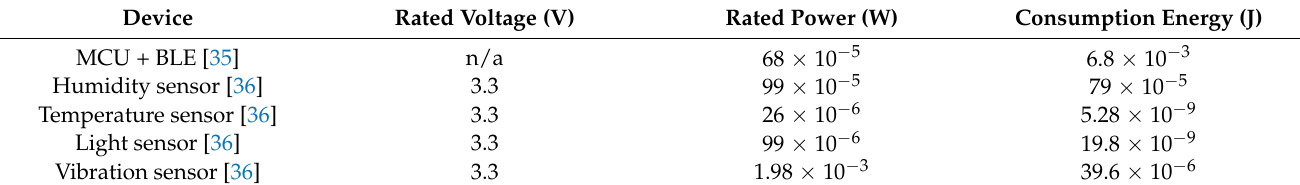
Figure 10. Electrical characteristics of TEHFT with the 0.2 mm PTFE film thickness: ( a ) output volt- age, current, and power across resistive loads; and ( b ) graph of output voltage and accumulated energy across the optimal load.